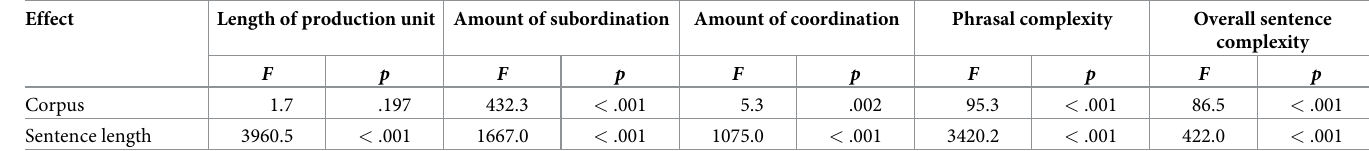
Table 5. ANOVA results for the by-subconstruct separate analyses.